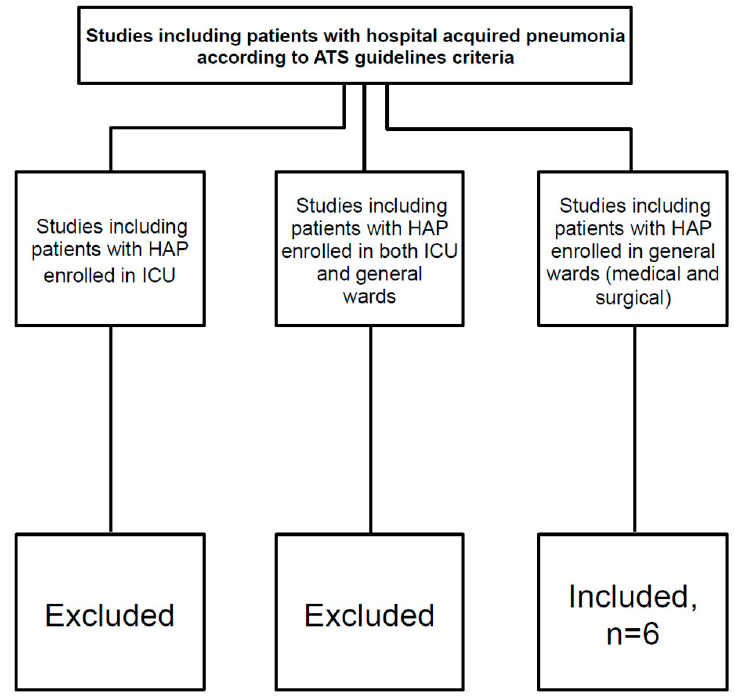
Figure 1. Inclusion and exclusion criteria used during the literature search. ATS American Thoracic Society, HAP hospital acquired pneumonia, ICU intensive care unit.